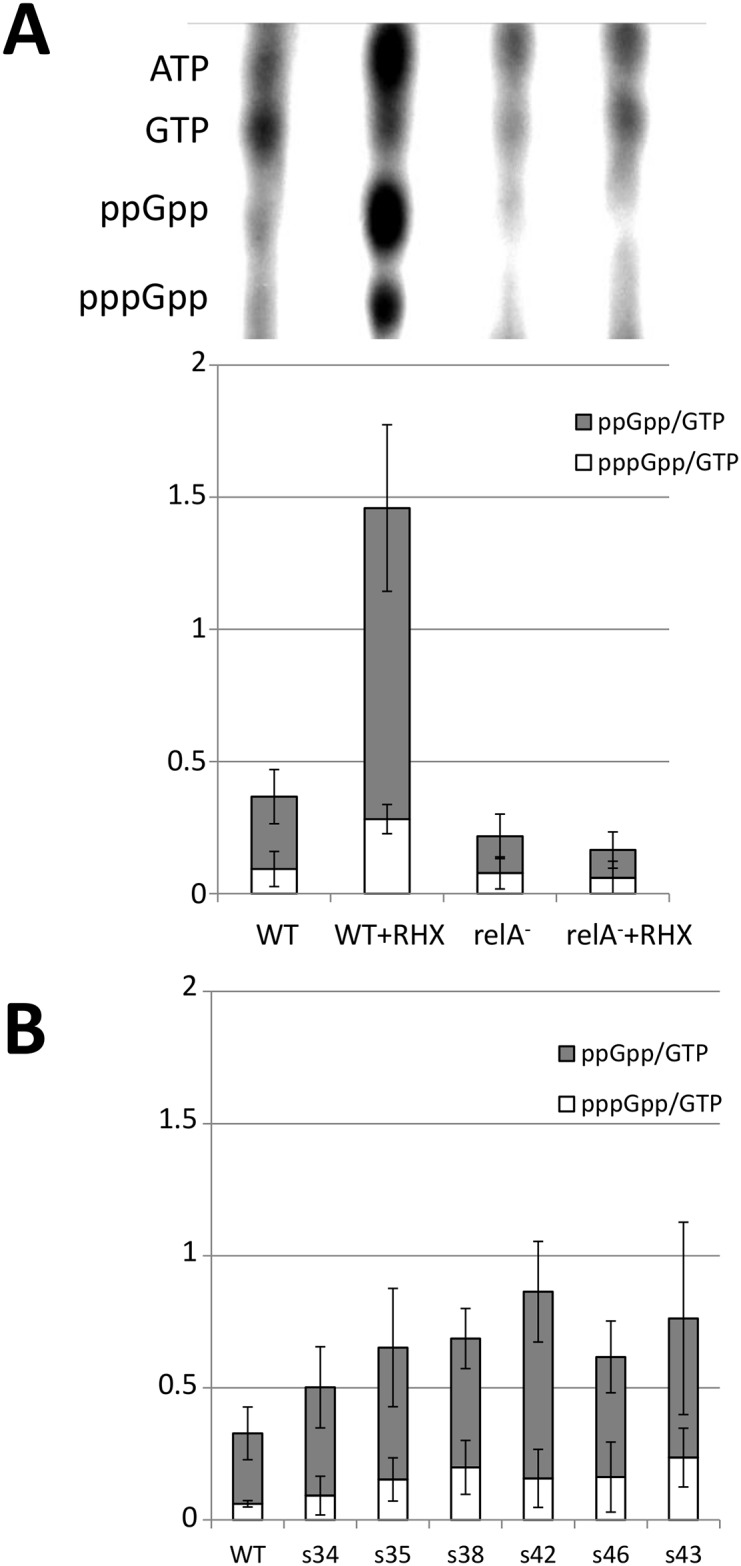
(p)ppGpp quantification.A. Wild type or relA mutant strains grown at 37°C in the MOPS derivative medium with or without arginine hydroxamate (100 μg/ml) were labeled with H3
32PO4 for 4 to 5 generations. The 32P labeled cells were collected and resuspended at the same final concentration in formic acid 1M and frozen. The reaction mixtures were centrifuged for 5 minutes at 8000g and 10μl of supernatant was used for TLC analysis. The position of the signal corresponding to pppGpp, ppGpp, GTP and ATP are indicated. For each strain the ratio of pppGpp/GTP (white) and ppGpp/GTP (grey) were calculated taking the phosphate stoichiometry into account. Each value corresponds to the means and the standard deviation of at least 3 experiments. B. One representative strain of each class of suppressors (with the exception of class VII which is unable to grow in the labeling condition) and the wild type strain were grown, labeled for 4 to 5 generations and the ratio of pppGpp/GTP (white) and ppGpp/GTP (grey) was determined on at least 3 independent experiments.